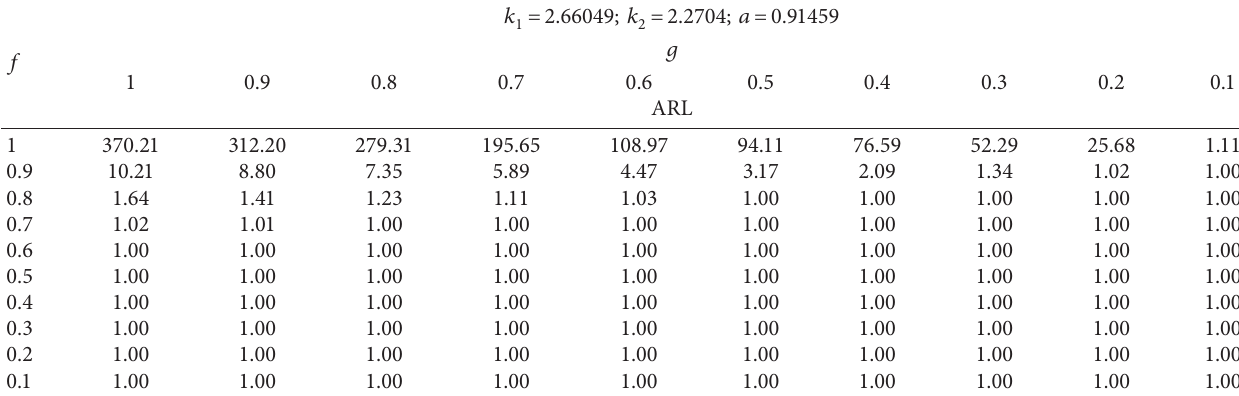
Table 1: The values of ARLs when b � 0.31, n � 20, and i � 3.